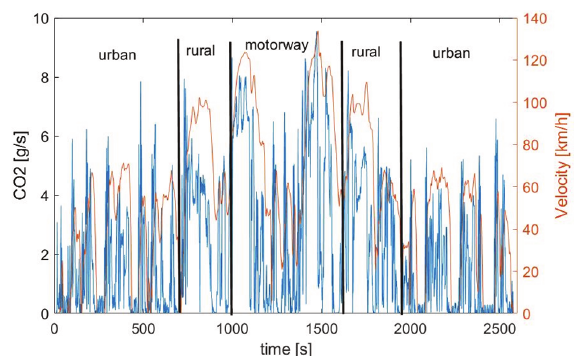
Fig, 4. Emission intensity of CO 2 for Euro 3 LPG fuelled vehicle